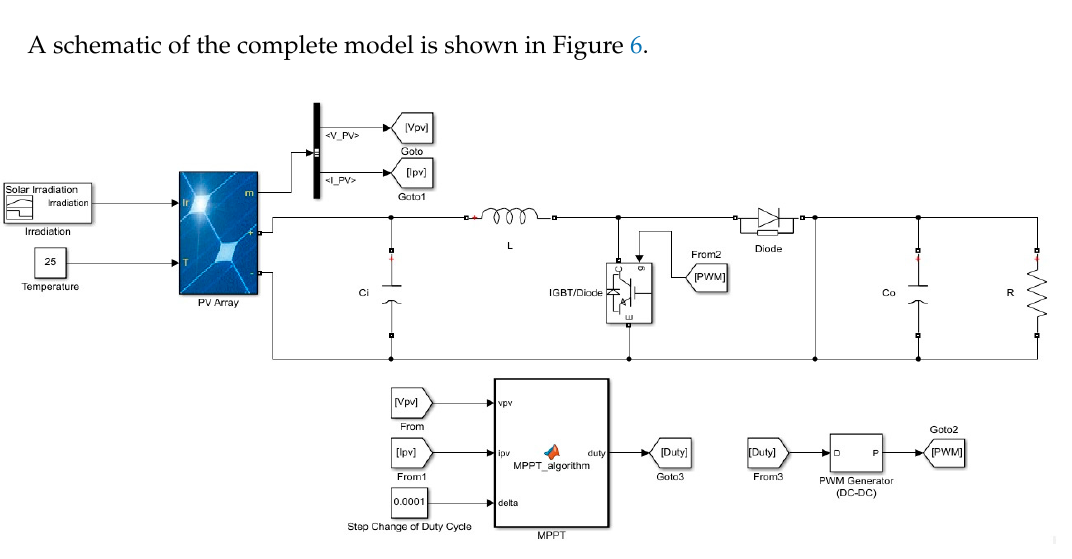
Figure 7. Time-varying and fast-changing dynamic solar irradiation signal.